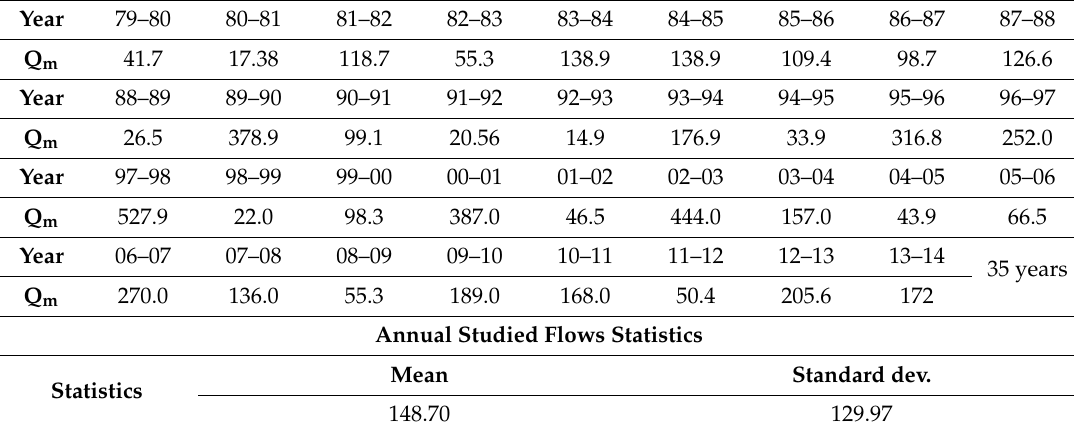
Table 1. Maximum annual instantaneous flow for each year of the series [58].